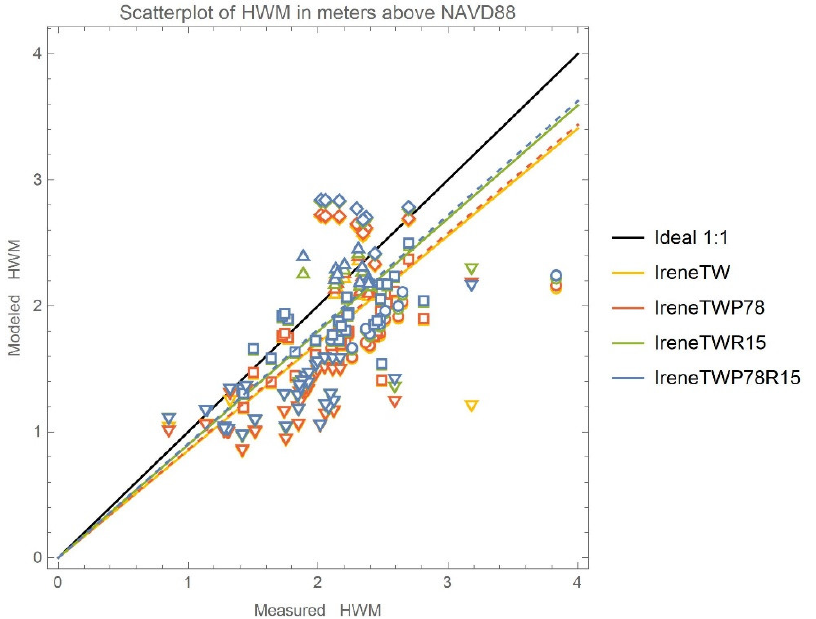
Figure 16. Comparison of HWM scatter plots with new source terms. Shapes correspond to the locations shown in Figure 6 (diamonds—Tar River, triangles—Upper Neuse River, squares—Tar/Neuse floodplains, circles—Lower Neuse River, inverted triangles—all Other locations). Simulation abbreviations as per Table 3.